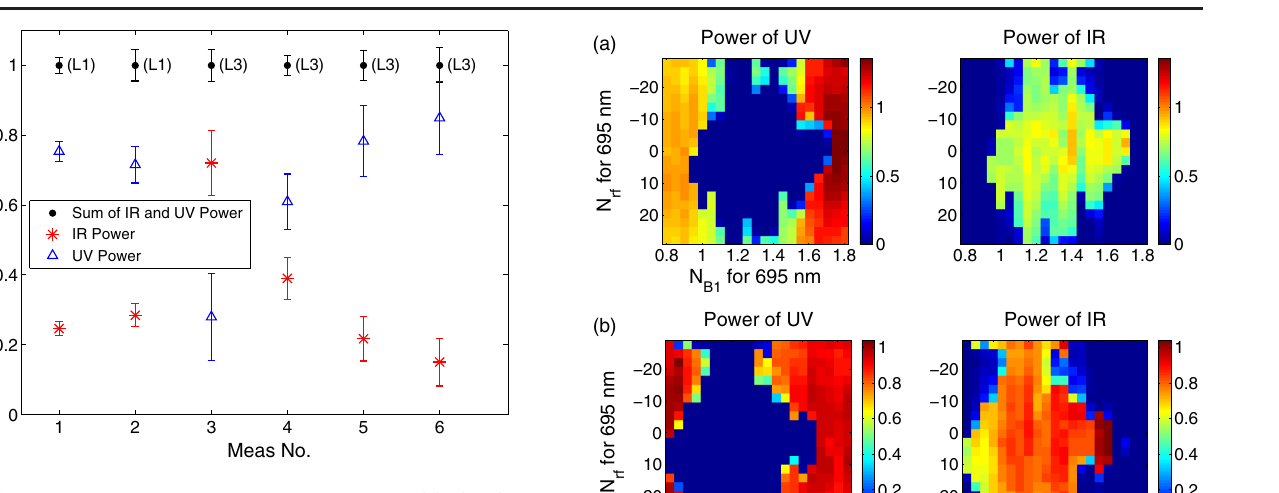
FIG. 10. Long-term FEL power measurements with the three- undulator configuration but different cavity losses. The data points and error bars represent the mean values and the rms variations of FEL power for the six 20-min measurements. The powers of each measurement are normalized to its sum of IR and UV power. Measurements no. 1 and no. 2 were taken with loss curves L1 and measurements no. 3 to no. 6 were taken with loss curves L3.